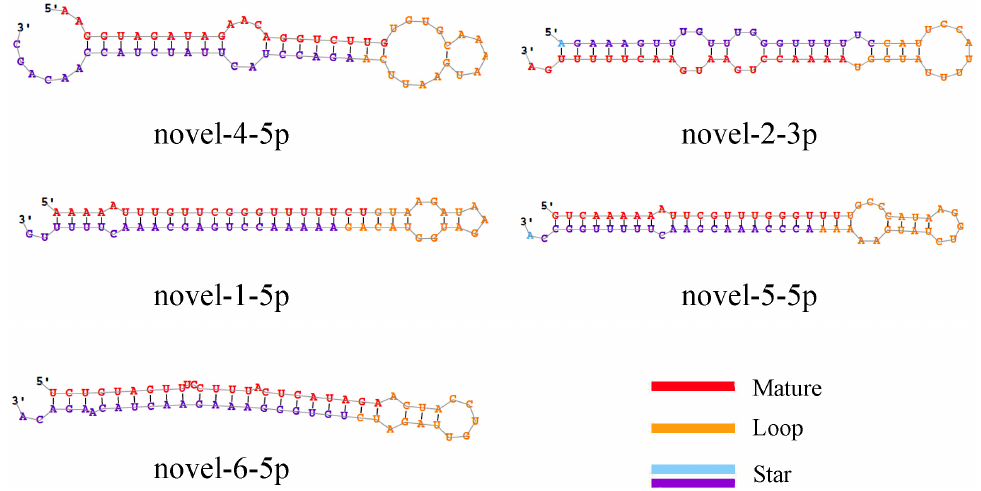
Figure 1. Predicted secondary structures of novel miRNAs. The red color indicates the mature sequence, the yellow color indicates the loop sequence, the blue color indicates the predicted star sequence, and the purple indicates the miRNA star sequences.